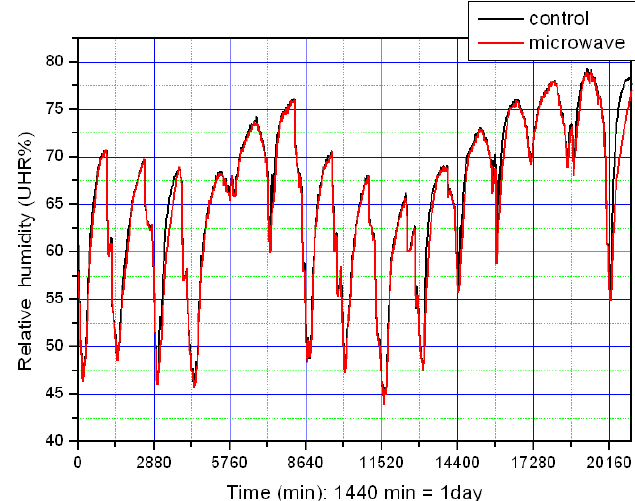
Figure 2. Humidity variation depending on the time in both